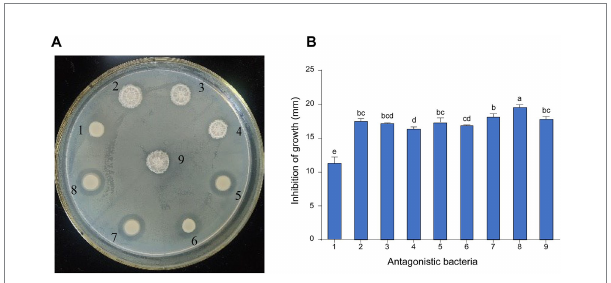
FIGURE 1 Screening and inhibition of E. amylovora by antagonistic